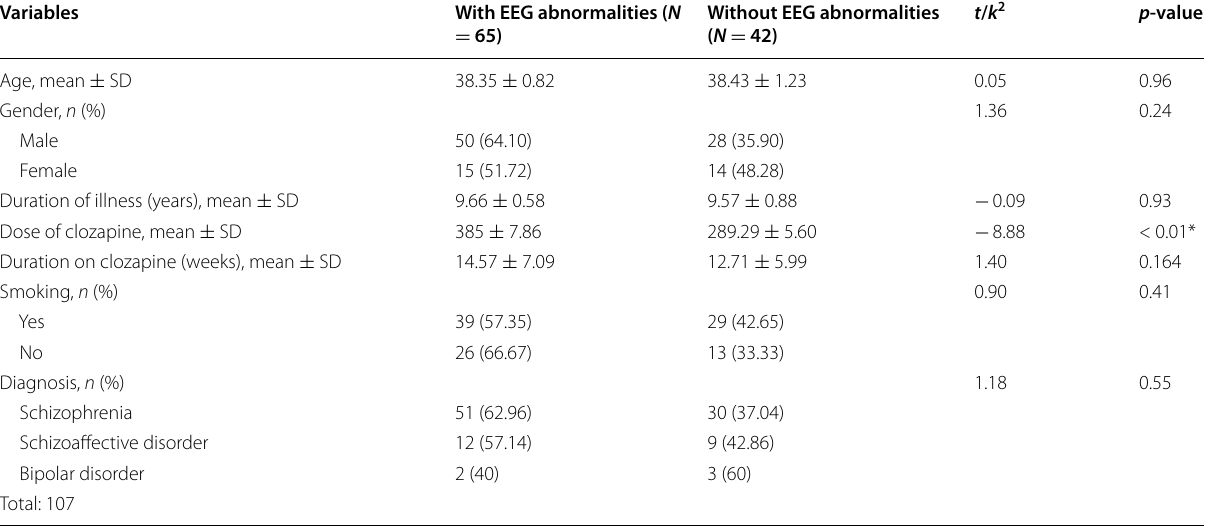
* p < 0.01 statistically